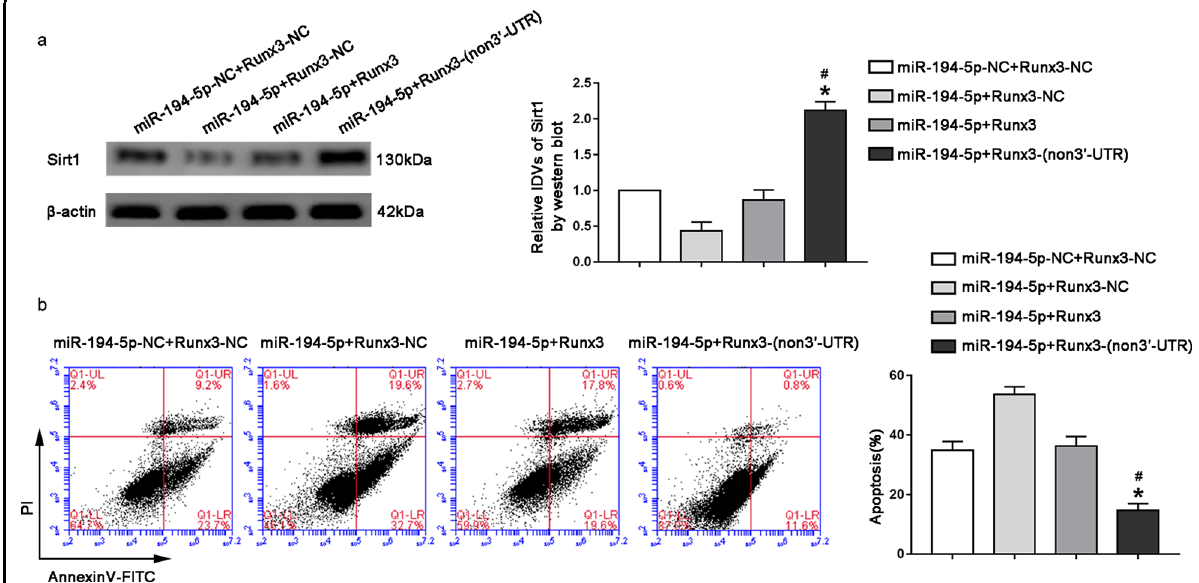
Fig. 5 Overexpression of miR-194-5p impaired Runx3-induced attenuation of CCI-induced neuronal apoptosis by targeting 3 ′ -UTR of Runx3. a Sirt1 protein levels in CCI-induced HT22 cells cotransfected with miR-194-5p and Runx3/Runx3-(non-3 ′ UTR). Data represented as mean ± SD. ( n = 3, each group) * P < 0.05 vs. miR-194-5p + Runx3-NC group, # P < 0.05 vs. miR-194-5p + Runx3 group. b Flow cytometry analysis of CCI- induced HT22 cells cotransfected with miR-194-5p and Runx3/Runx3-(non-3 ′ UTR) with annexin V/PI staining. Data represented as mean ± SD. ( n = 3, each group) * P < 0.05 vs. miR-194-5p + Runx3-NC group, # P < 0.05 vs. miR-194-5p + Runx3